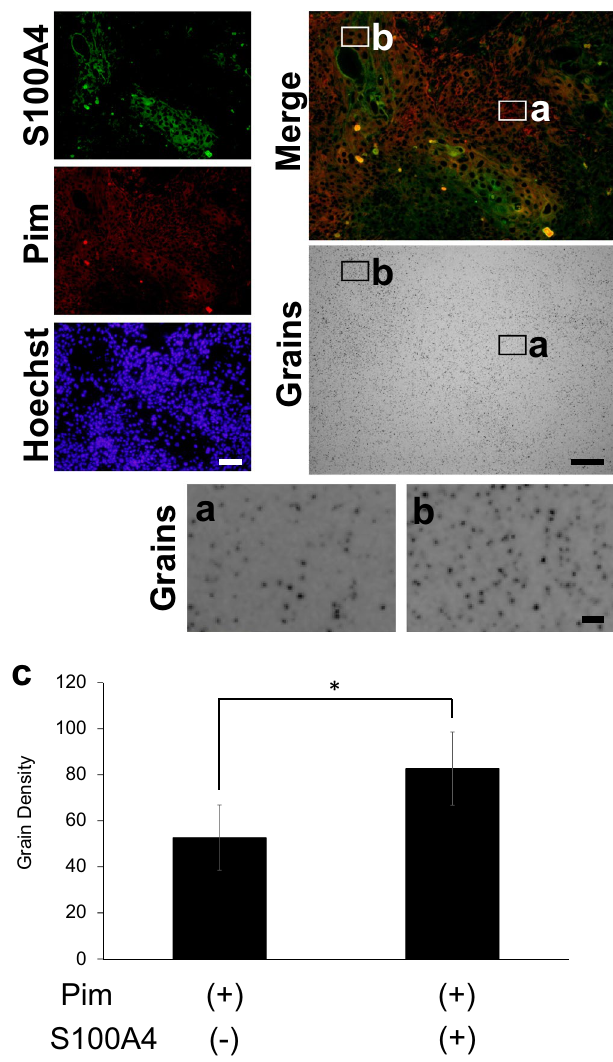
Figure 6. 18 F-FDG accumulation in hypoxic tumor cells expressing human S100A4. ( a ) Magnified view of micro-autoradiographic image showing the pimonidazole-positive and S100A4-negative area, and ( b ) the pimonidazole-positive and S100A4-positive area. ( c ) Determination of grain density in pimonidazole-positive and S100A4- negative or positive area focusing on ROIs of the same size (n = 3, mean ± SEM, Student t -test, one- sided, *: p < 0.05). Pim: Pimonidazole. Bars: 100 μm (S100A4, Pimonidazole, Hoechst, Merge and Silver grains), 10 μm ( a , b